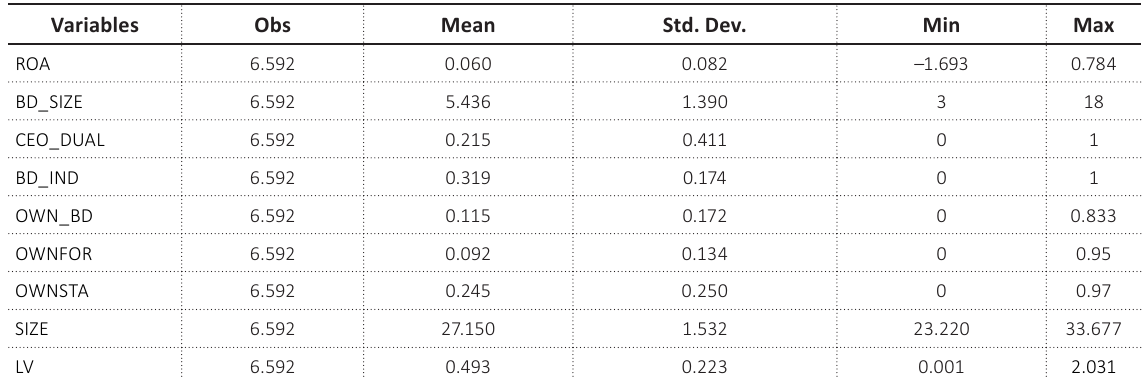
Table 2. Descriptive statistics of